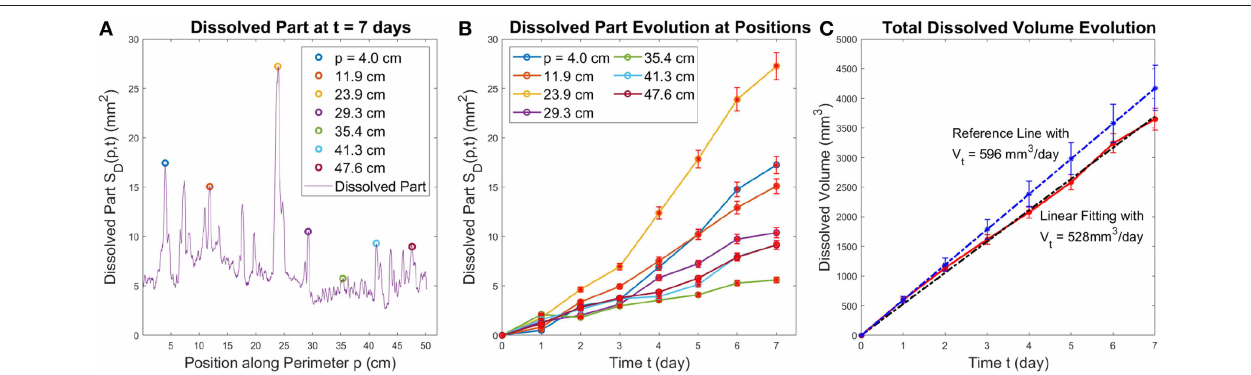
FIGURE 9 | The left panel (A) shows the local dissolved part along the perimeter, S D ( p , t ) at t = 7 days. The positions corresponding to the individual fingers, at p = [4.0, 11.9, 23.9, 29.3, 35.4, 41.3, 47.6] cm are marked with color circles. The center panel (B) displays the growth of S D ( p i , t ) at these positions with error bars. The right panel (C) shows the total dissolved volume as a function of time (red line) together with a linear fit (black line) and the theoretical estimate (blue line) with the corresponding error bars. The overlap between error bars show the experimental measurement fits well with the theoretical